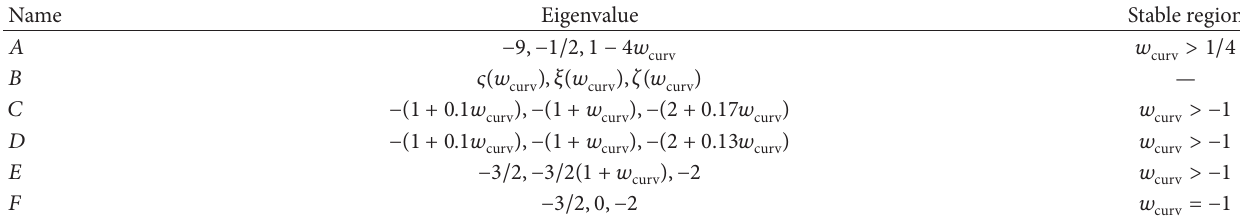
= −1 is a stable de Sitter phase. curv